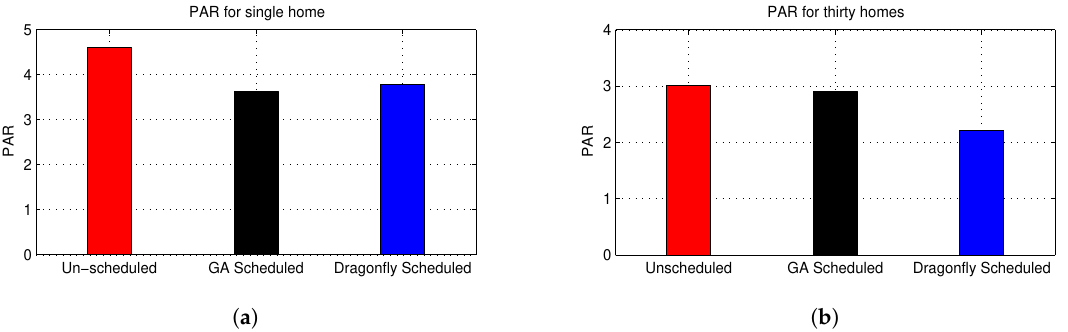
Figure 9. PAR for un-scheduled and GA and DA scheduled load ( a ) single home; ( b ) 30 homes.